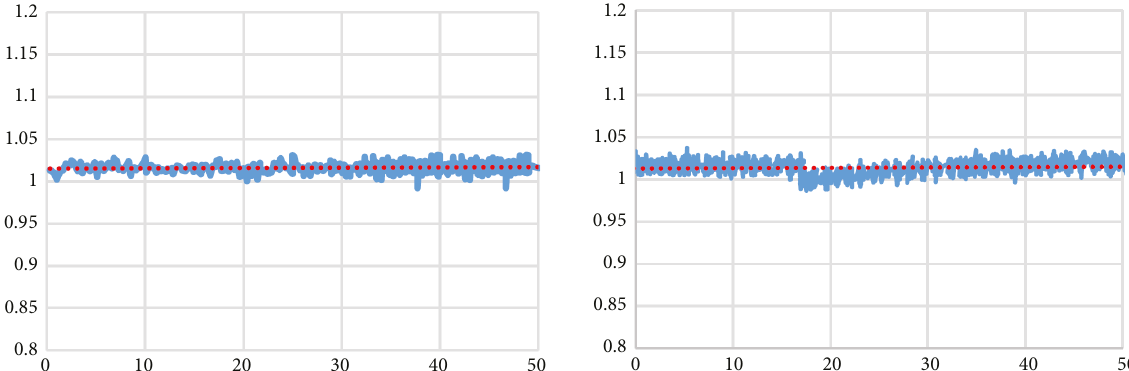
Figure 5: Dependence of the accelerometer Y-axis values (1g – 9.81 m/s 2 ) upon the temperature during slow (1 ∘ C/min) heating (left) and cooling (right).